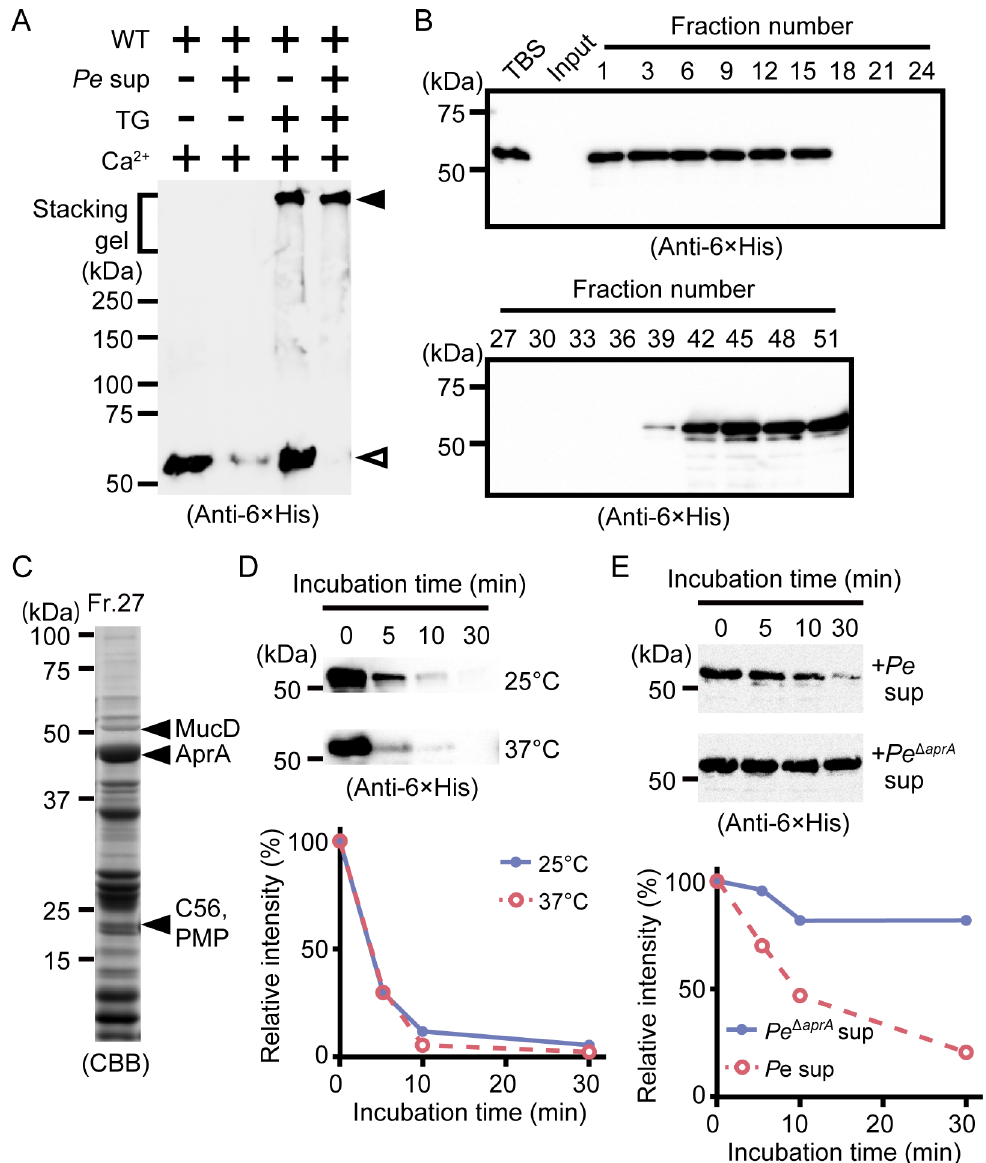
Fig 3. Polymerized drosocrystallin protects against AprA. (A) Wild-type drosocrystallin (WT) was incubated at 37°C for 30 min with or without TG, and then the culture supernatant from P. entomophila (Pe) was added, and the mixture was subjected to SDS-PAGE in 10% TGX FastCast gels. Open arrowhead, the monomeric recombinant; closed arrowhead, the crosslinked recombinant. Data are representative of at least three independent experiments. (B) Wild-type drosocrystallin was subjected to SDS-PAGE in 10% slab gels and detected by Western blotting after incubating with each fraction obtained by gel filtration of the culture supernatant from P. entomophila. (C) Fraction No. 27 from the gel filtration was subjected to SDS-PAGE in 15% slab gels, and proteases in this fraction were identified by liquid chromatography tandem mass spectroscopy analysis. (D) Wild-type drosocrystallin was incubated with purified AprA at 25°C or 37°C and analyzed by SDS-PAGE in 10% slab gels, and detected by Western blotting using anti-6 × His tag antibody (upper panel). Western blotting data are representative of four independent experiments. The relative intensity of each band compared to that of the untreated protein (0 min) was calculated using ImageJ software (lower panel). (E) Wild- type drosocrystallin was incubated with the culture supernatant from P. entomophila (Pe) or the AprA-knockout strain (Pe Δ aprA), analyzed by SDS-PAGE in 10% slab gels, and detected by Western blotting using anti-6 × His tag antibody. Western blotting data are representative of three independent experiments (upper panel). The relative intensity of each band compared to that of the untreated protein (0 min) was calculated using ImageJ software (lower